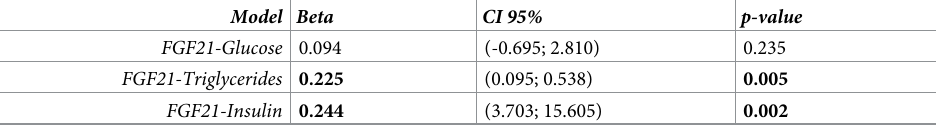
Table 5. Multivariable analysis for FGF21 and biochemical parameters in HIV- seropositive individuals.